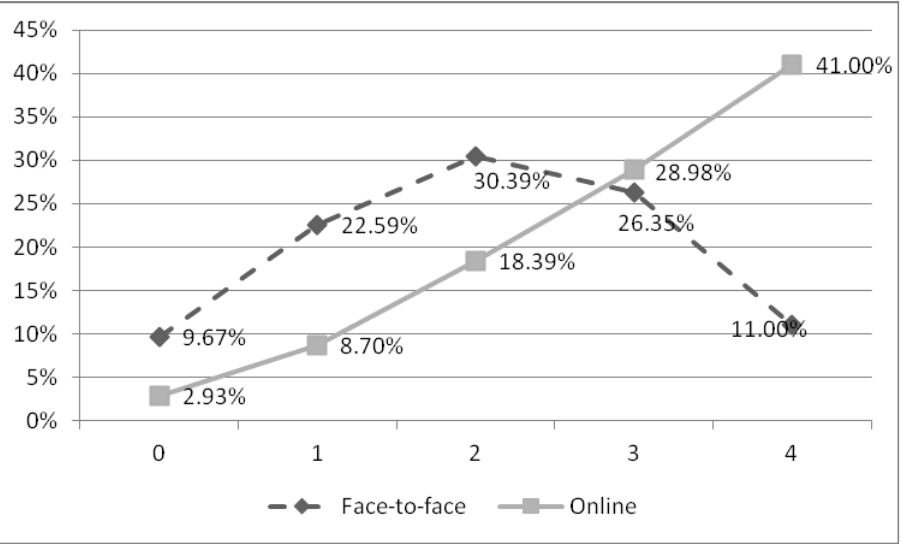
Figure 1 . Indicator of intensity of academic uses of the Internet for